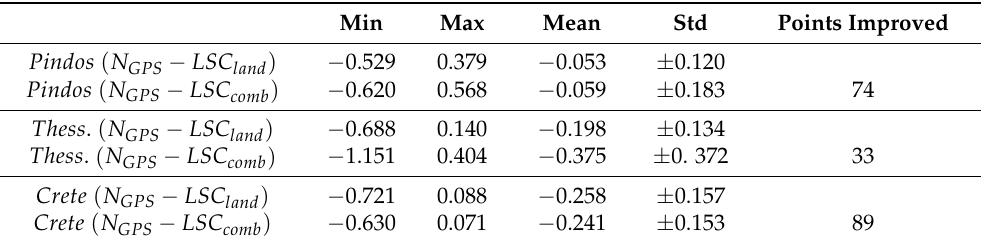
Figure 16. GNSS/levelling BMs over Pindos with improved differences when using the LSC com- bined model (blue dots) and BMs where the LSC with land gravity is better (red dots).